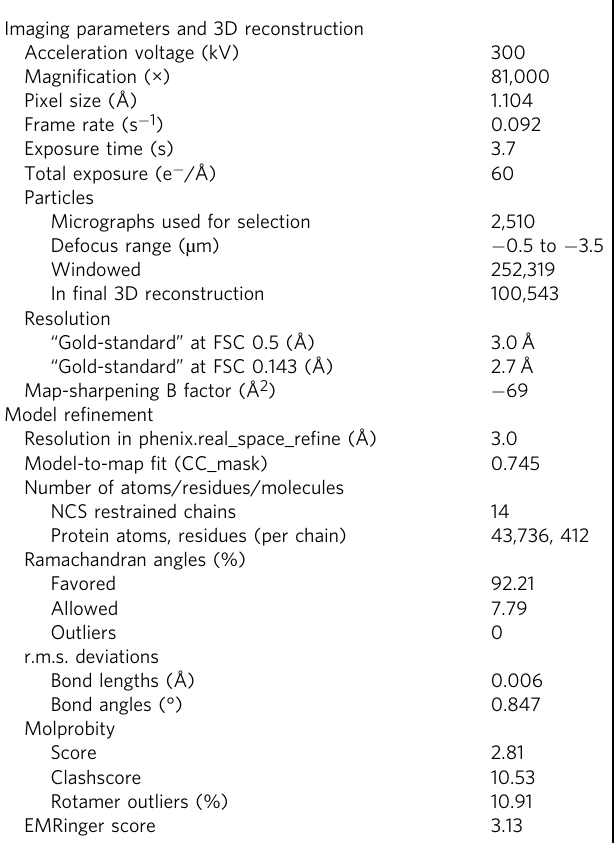
Table 1 Summary of single-particle data collection, 3D reconstruction, and model re fi nement. Imaging parameters and 3D reconstruction Acceleration voltage